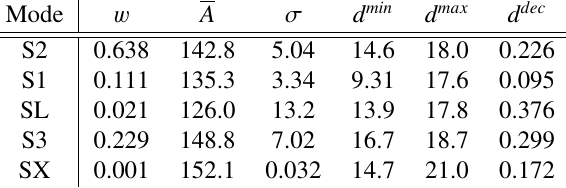
Table 2. Brosa parameters corresponding to the CGMF calculation in the last row of Table 1.